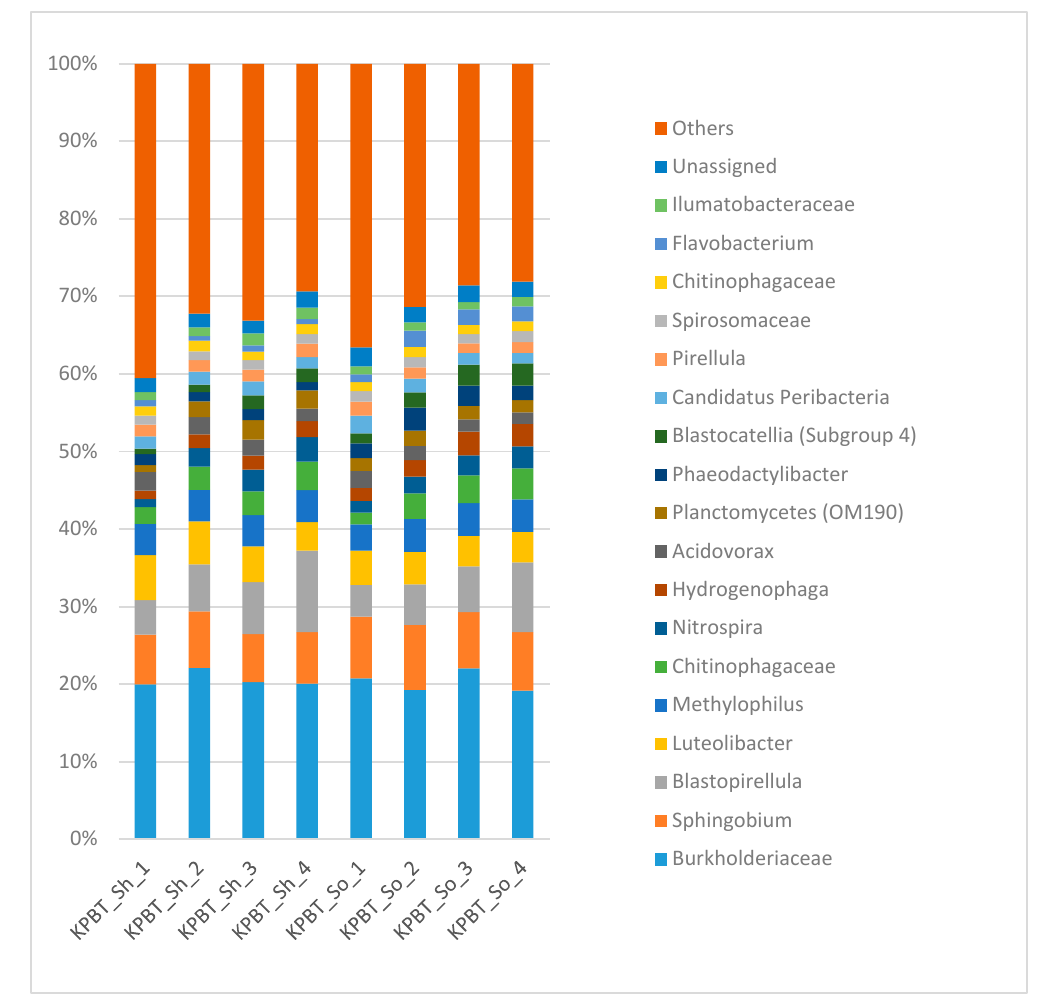
Figure 6. Overview of the taxonomic profile at genera level for the microbiota harvested from lettuce rhizoplane. Each column represents all the detected genera of each of the four successive washes with KPBT So and KPBT Sh protocols. Each color represents an OTU. Only the OTUs with high proportion (1% of the total reads) are presented and the rest are grouped as others. The numbers (from 1 to 4) associated to the protocols are successive washes.